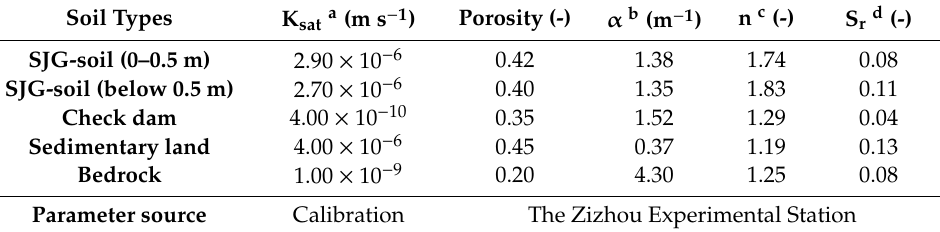
Table 3. Soil parameters used in InHM for the eight scenarios.